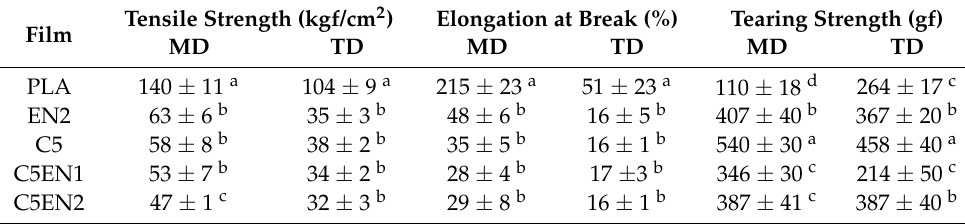
Table 1. Tensile strength, elongation at break, and tearing strength of PLA, EN2, C5, C5EN1, and C5EN2 films.